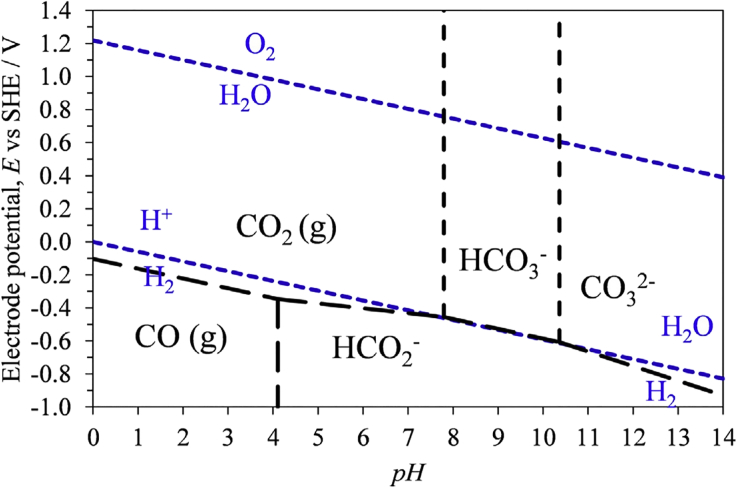
Meta-stable Potential-pH (Pourbaix) Diagram for a C-H2O System at 298 K and 1 BarReproduced with permission from (Bumroongsakulsawat and Kelsall, 2014).